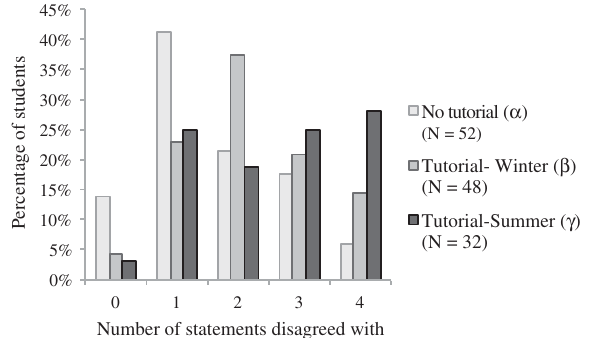
FIG. 6. The number of statements that students disagreed with. Only students who answered all four of the questions were included in these data.